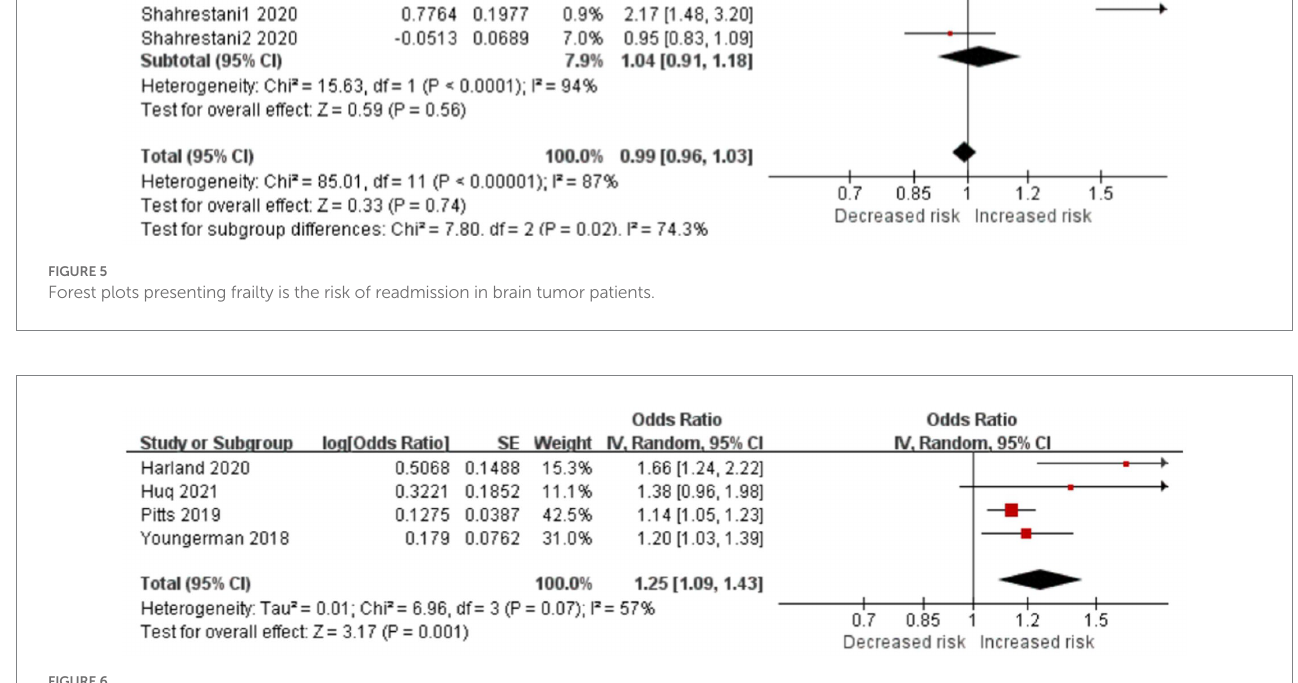
FIGURE 6 Forest plots presenting frailty is the risk of LOS in brain tumor